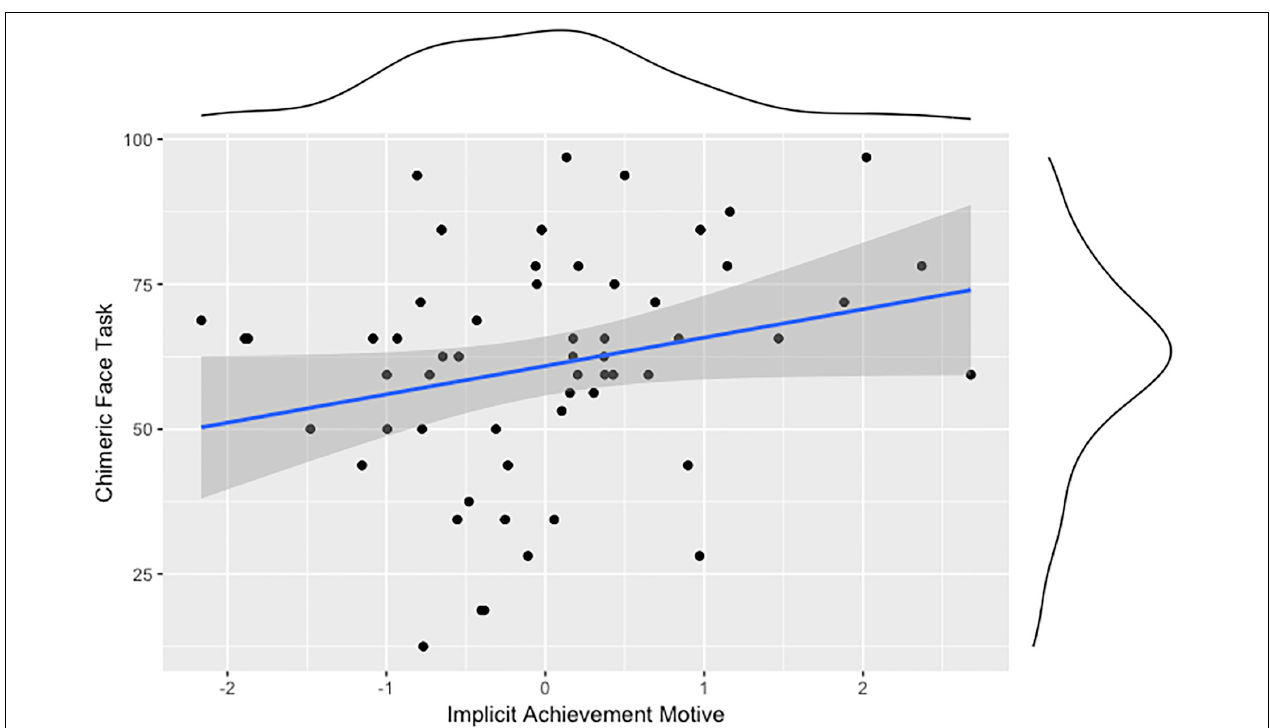
FIGURE 1 | Association between the implicit achievement motive and cognitive-behavioral indicators of rightward brain laterality (CFT).